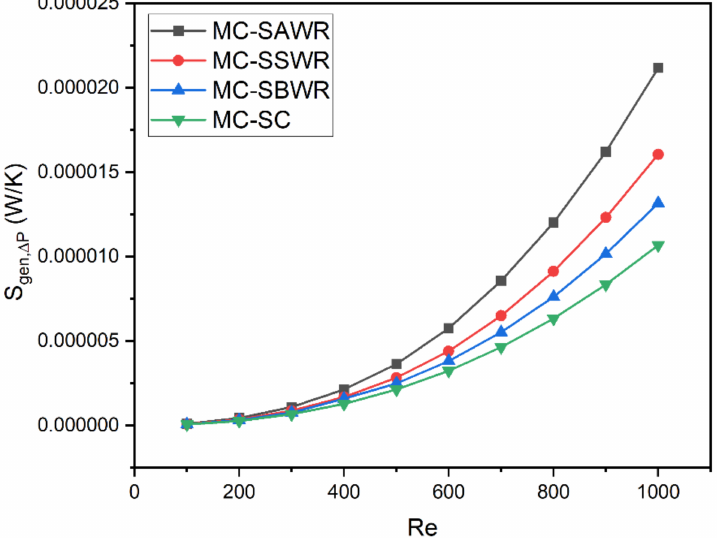
. S gen , ∆ P ) with Re for various